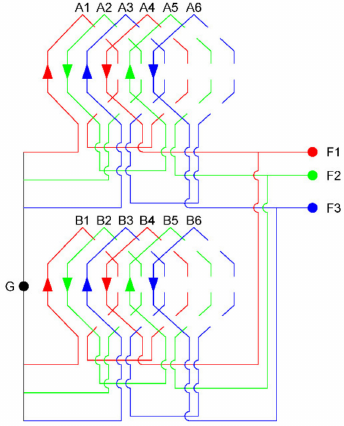
Figure 4. Connection scheme of